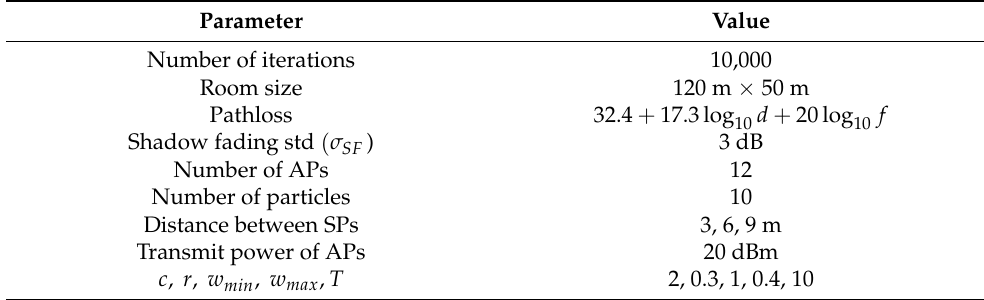
Table 1. Simulation